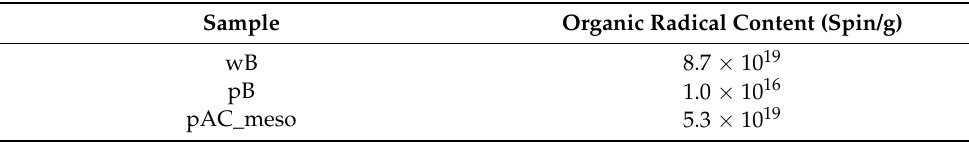
Table 2. Organic radical content of the samples